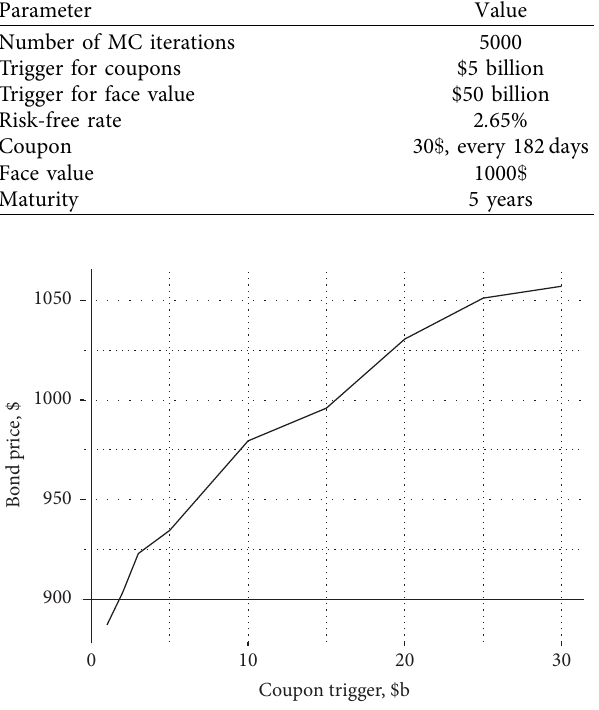
Figure 2: Cyber bond price vs. coupon trigger.